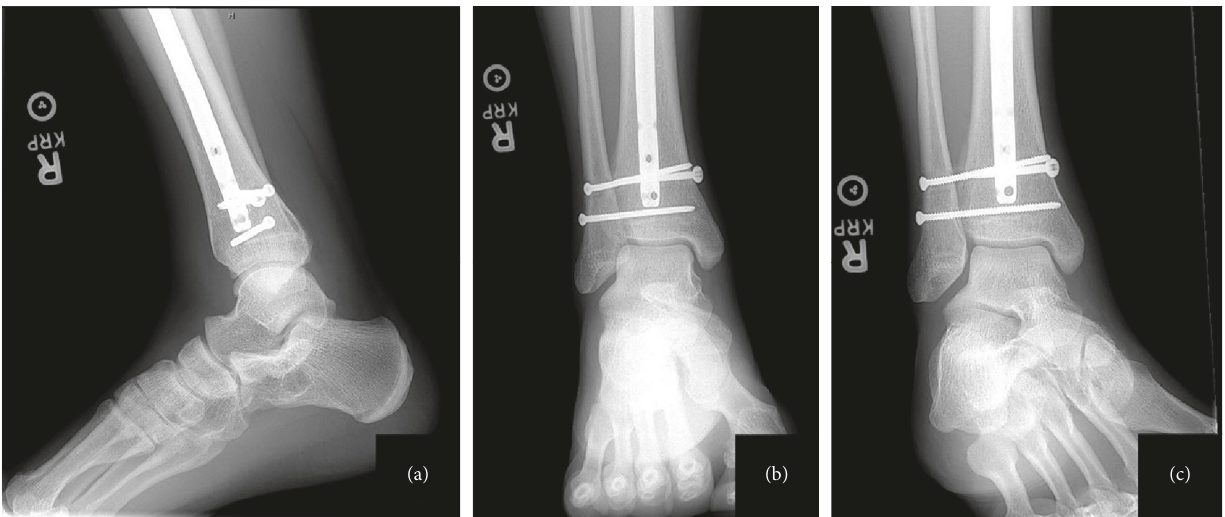
Figure 3: Postoperative lateral (a), AP (b), and mortise (c) radiographs showing 2 quadricortical screws stabilizing the syndesmosis with no evidence of hardware